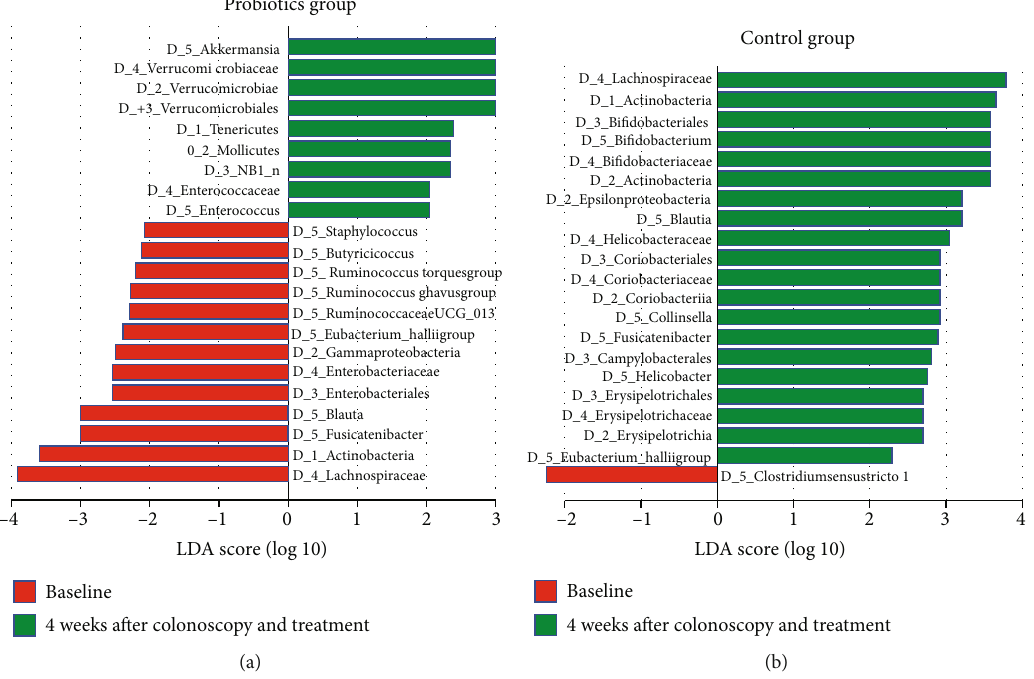
Figure 3: Di ff erences in the composition of the gut microbiota between the baseline and 4 weeks after colonoscopy and treatment groups. Gut bacteria with linear discriminant analysis score > 2 : 0 between the baseline and 4 weeks after colonoscopy and treatment in the probiotics group (a) and control group (b) at the levels of class, order, family, and